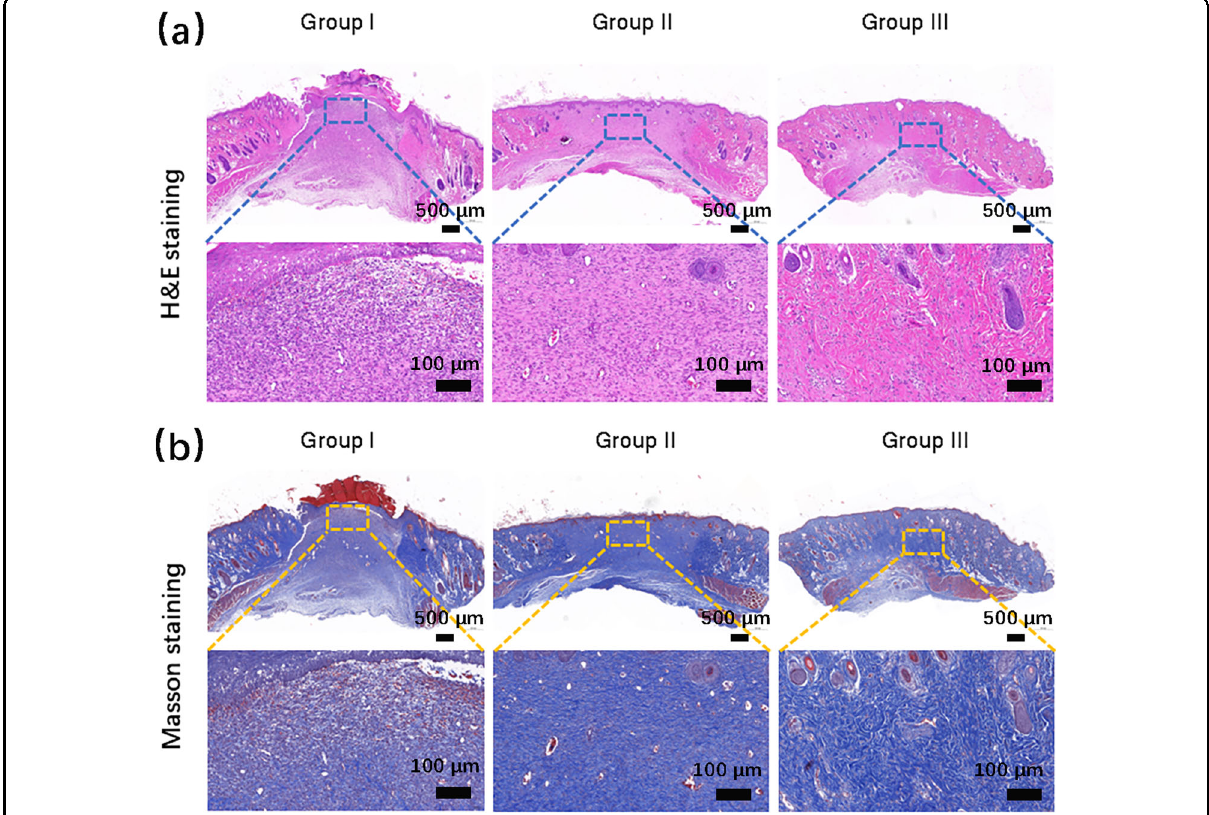
Fig. 4 Evaluation of wound healing with NC hydrogle. a H&E and ( b ) Masson staining of wounds on Day